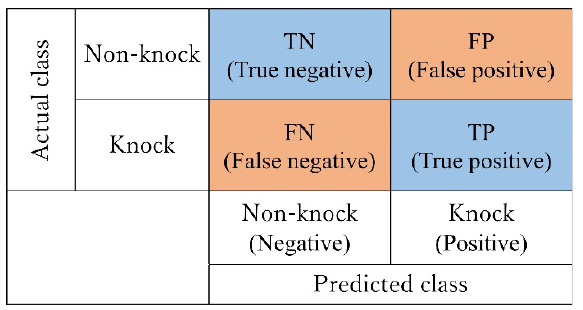
Figure 3. Confusion matrix.